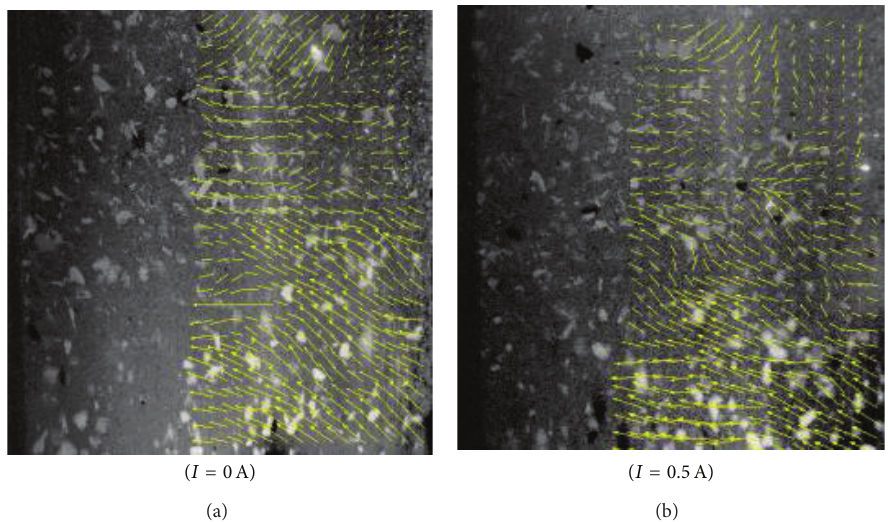
Figure 4: Velocity distribution at V = 1000 r/min, ℎ = 10 mm, and 𝑡 = 100 s.